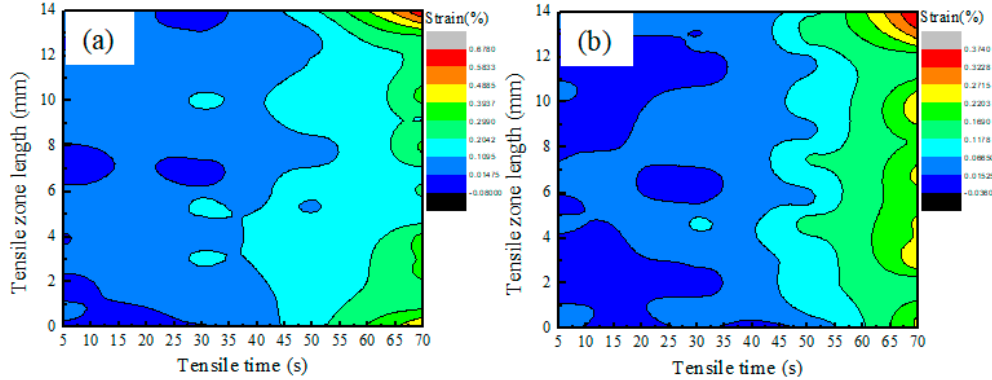
Figure 12. Cloud images of strain of transversal and longitudinal specimens. ( a ) Transversal ( b ) longitudinal specimen. specimen; ( b ) longitudinal specimen.